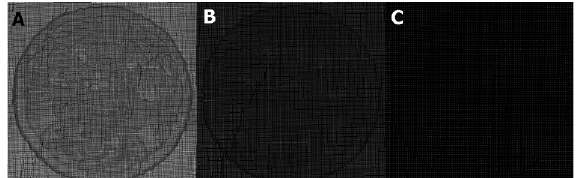
Fig ure 8. Point clouds of the test object, colour by intensity (greyscale) acquire from a 10 m distance, with resolution 1/1 (A), 1/2 (B) and 1/4